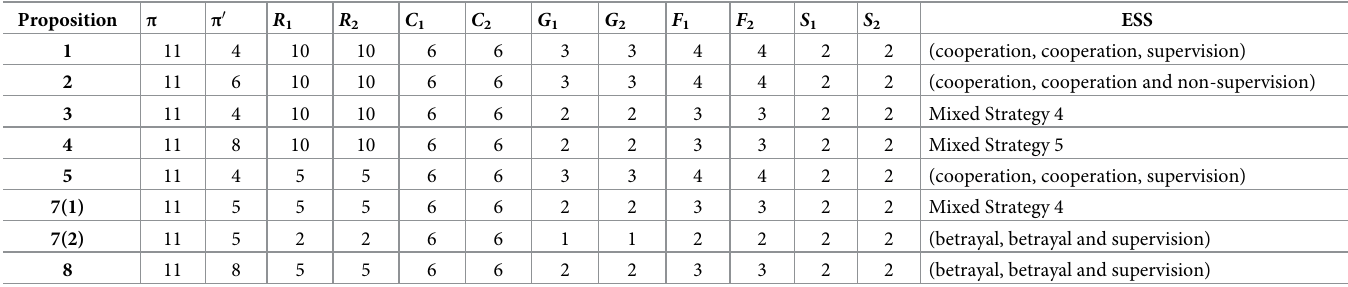
Table 7. Parameters of evolutionary game for each proposition of the